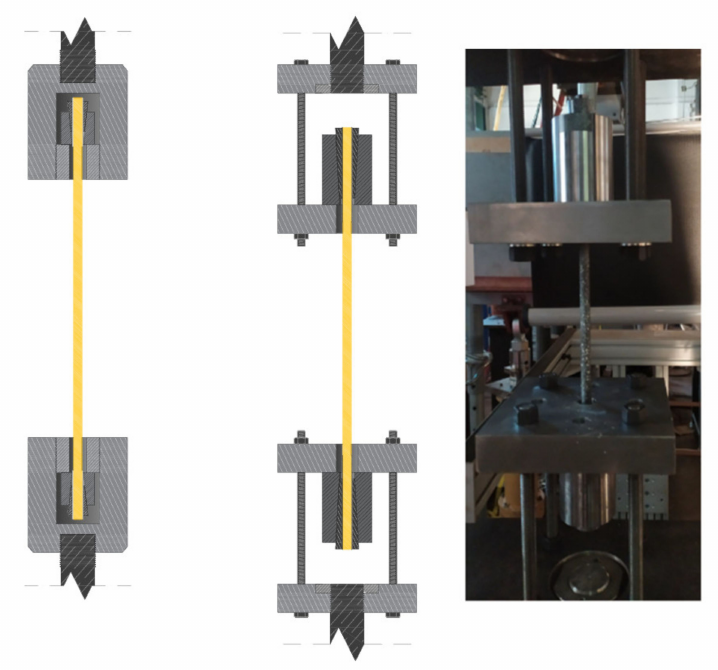
Figure 21. Test setup—Left: traditional anchorage; Right: Single and Double-Angle anchorage (schematic and